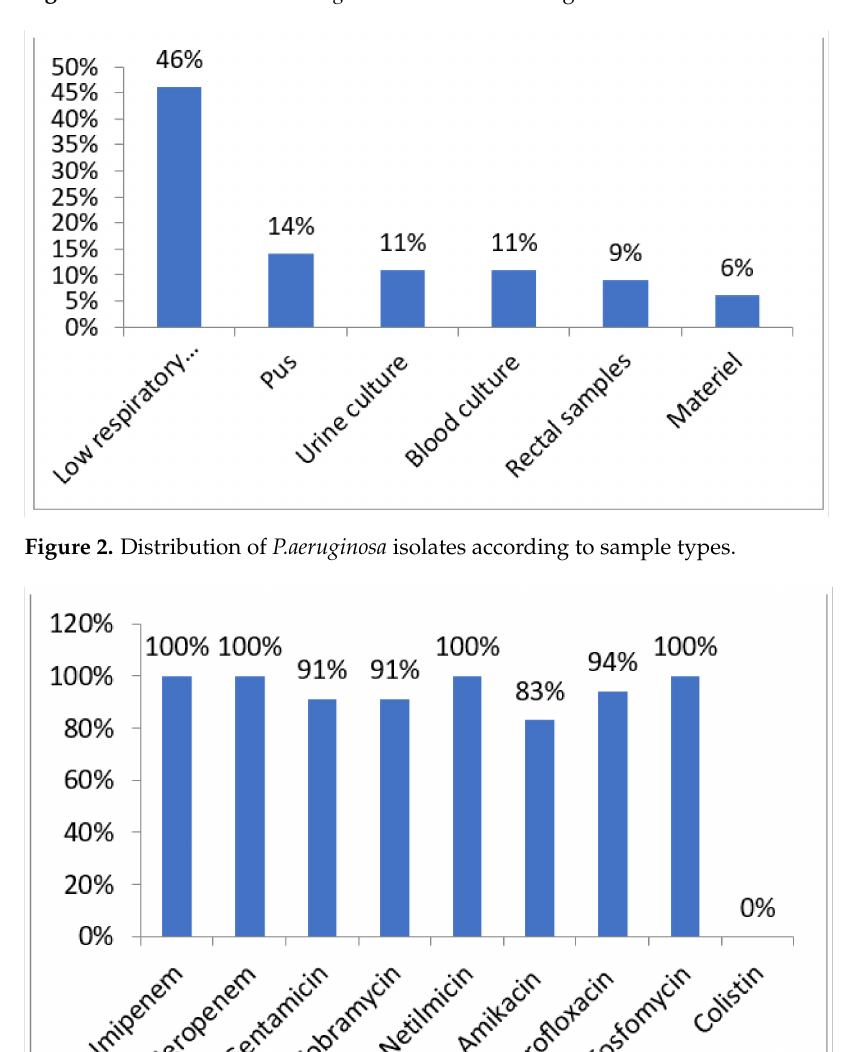
Figure 1. Distribution of P. aeruginosa isolates according to wards.